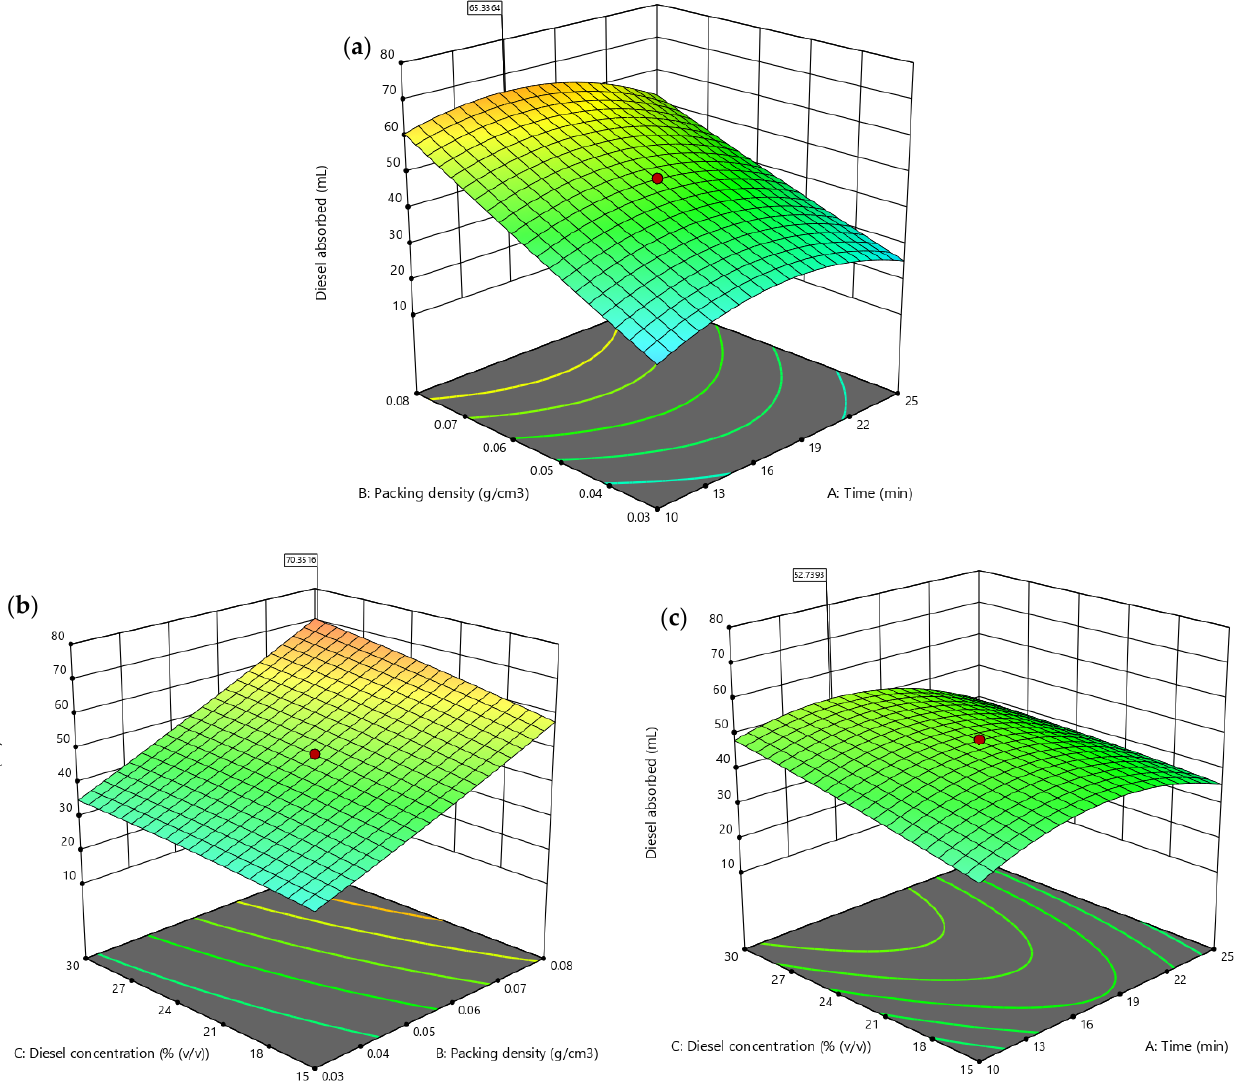
Figure 9. Three-dimensional response surface contour plots generated through Design Expert 13.0 (Stat Ease, Inc., Minneapolis, MN, USA.) displaying the interacting model terms; ( a ) A: time and B: packing density, ( b ) B: packing density and C: diesel concentration, and ( c ) A: time and C: diesel concentration.